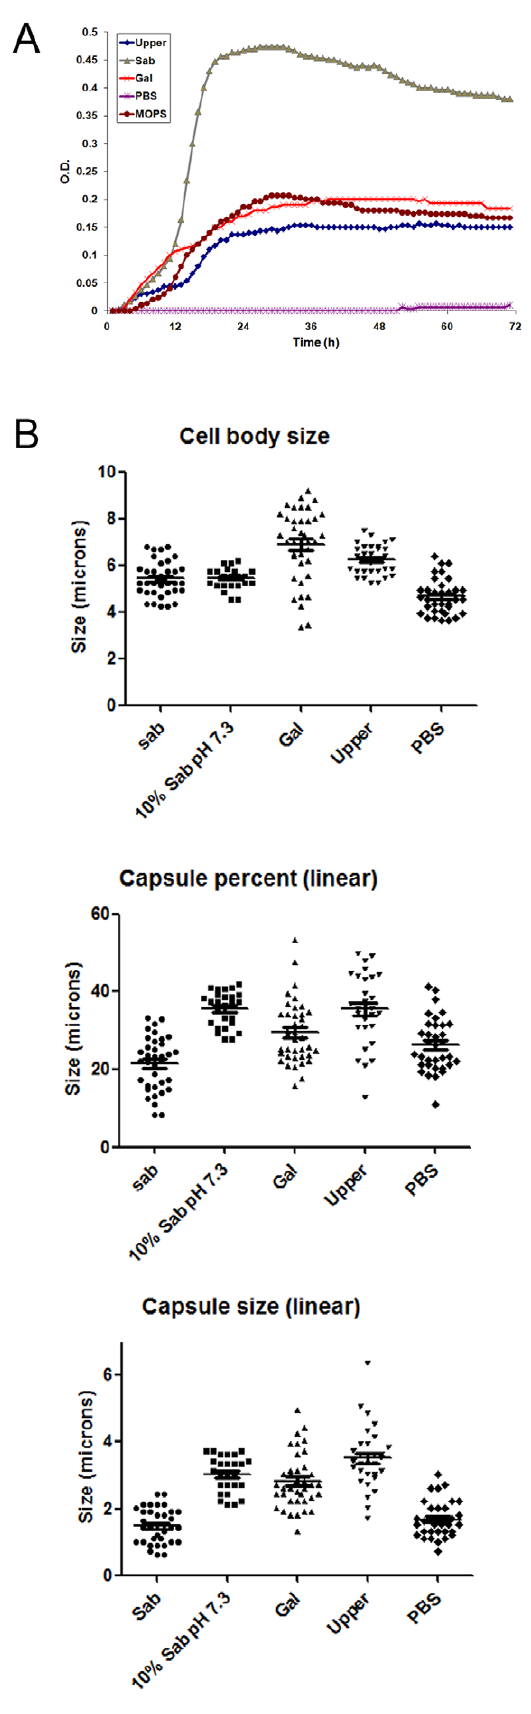
Figure 6. In vitro capsule and cellular enlargement of C. neoformans in G. mellonella extracts. Larvae were homogenized and different extracts were prepared as described in Material and N Methods. A ) Growth curves in Sabouraud ( m ), 10% Sabouraud diluted ), total G. mellonella extract ( x ), Upper phase in 50 mM MOPS pH 7.3 ( of G. mellonella extract, containing polar lipids ( ¤ ) and PBS (*) at 37 u C during 3 d. B ) Distribution of total cell size, cell body size and capsular diameter of C. neoformans cells in Sabouraud (Sab), Sabouraud buffered with MOPS (10%Sab pH 7.3), G. mellonella extract (Gal), upper phase of G. mellonella lipid extraction (Upper phase) and PBS at 37 u C for 10 d. T- test comparing cells in different media to cells grown in Sabouraud broth and scatter plot graphs were done using Graph Pad Prism 5. The line in each sample denotes the average of the distribution. P , 0.05 is indicated with an